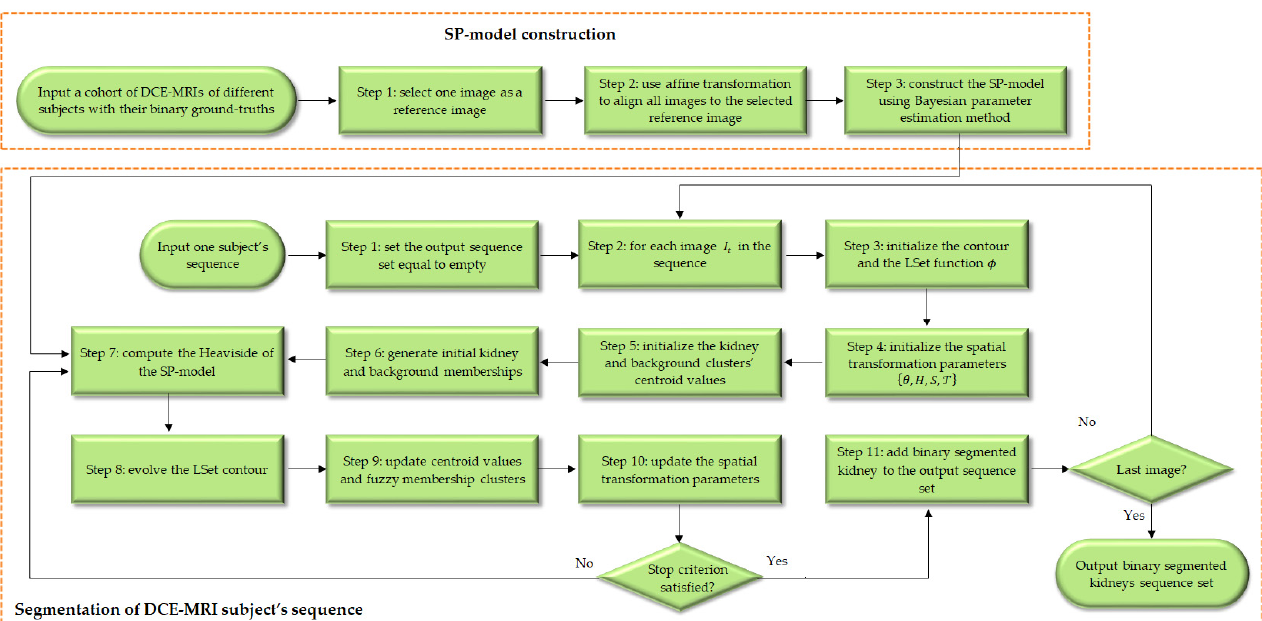
Figure 3. Flowchart of the proposed variational approach for DCE-MRI kidney segmentation and registration.